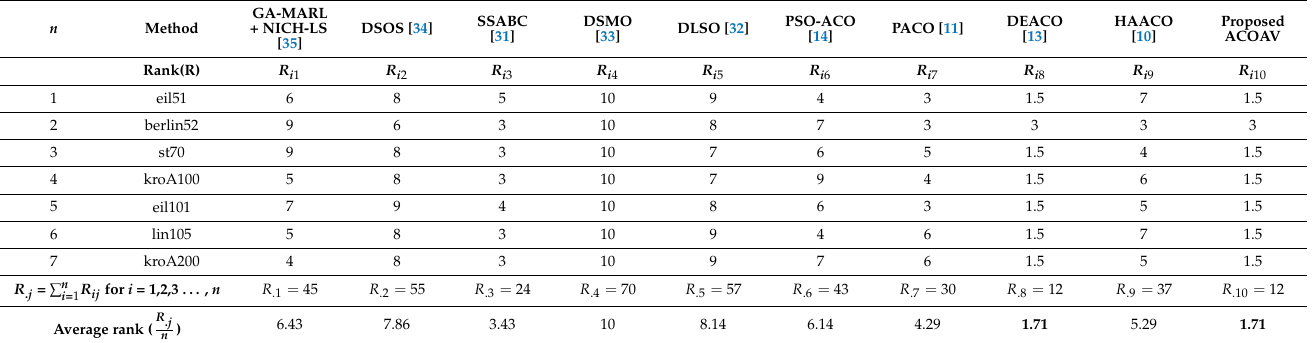
Table 4. Ranking of the Friedman Test among proposed ACOAV and Existing State-of-the-Art Bio-inspired